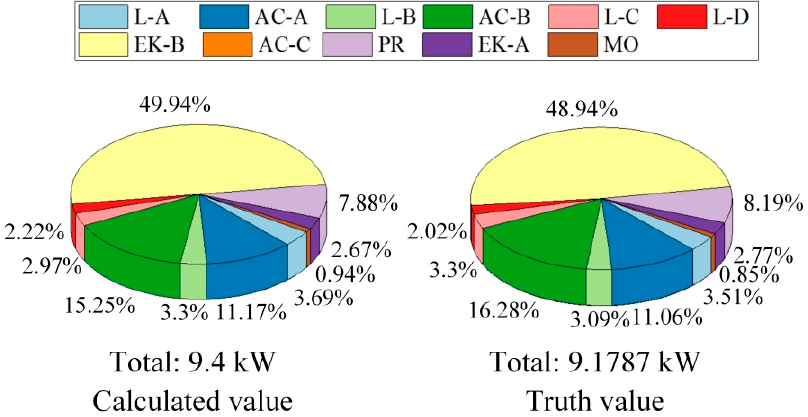
Figure 15. Comparison chart between identification load and actual power consumption results of day1–day3.